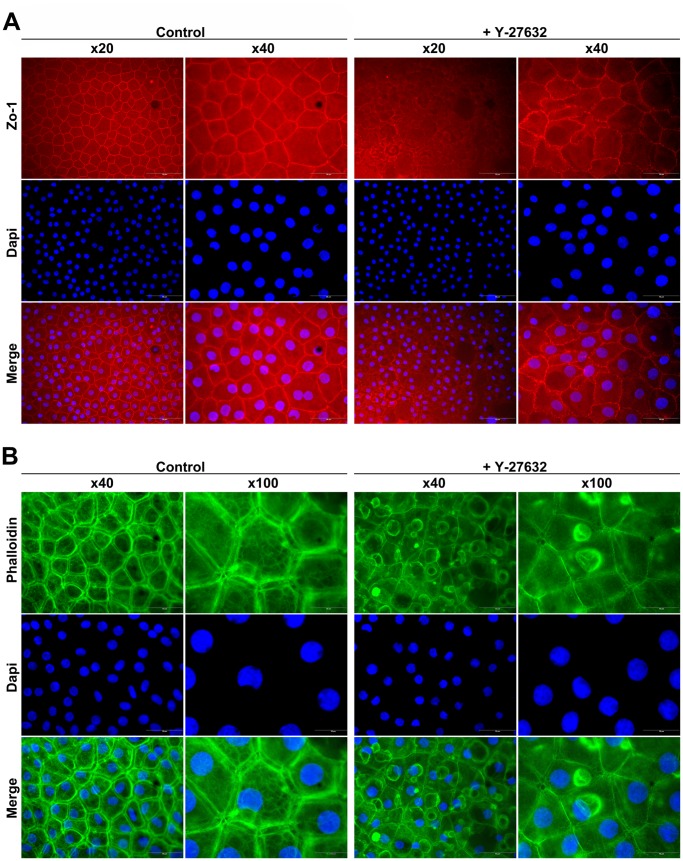

Ex vivo morphological assessment.(A) Zo-1 immunostaining. In control corneas, endothelial cells appear as a mosaic of cells with polygonal shape. Addition of Y-27632 induces a morphological change with a loss of the polygonal shape and an irregular cell border, suggesting a disruption of the tight junctions. (B) Actin staining. In control corneas, actin filaments are assembled into large radial and circumferential bundles, with a main localization along the membrane of the endothelial cells. After treatment the distribution of F-actin are altered, with only a residual staining associated with the cell periphery. The formation of circular membrane ruffles of variable size and actin content can also be observed.